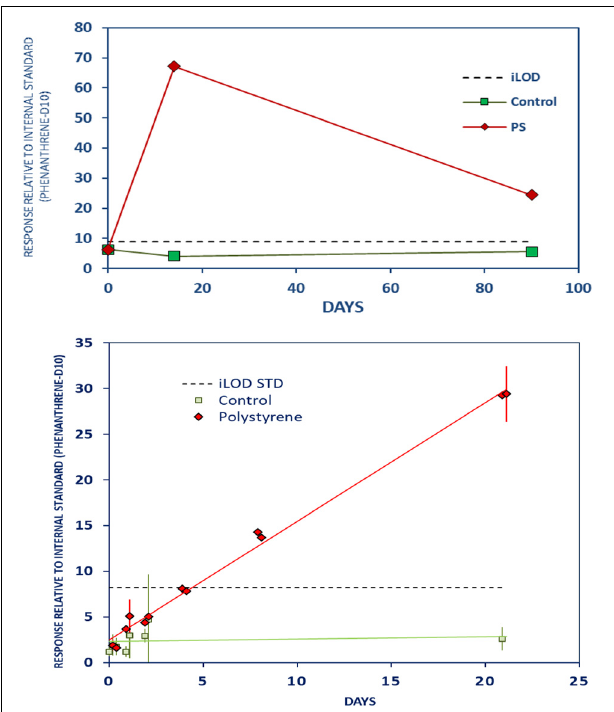
FIGURE 4 | Strong initial leaching of phenyl benzoate from PS to stomach oil with decrease in leachate concentrations between 14 and 90 days. Further caption details as in Figure 2 .